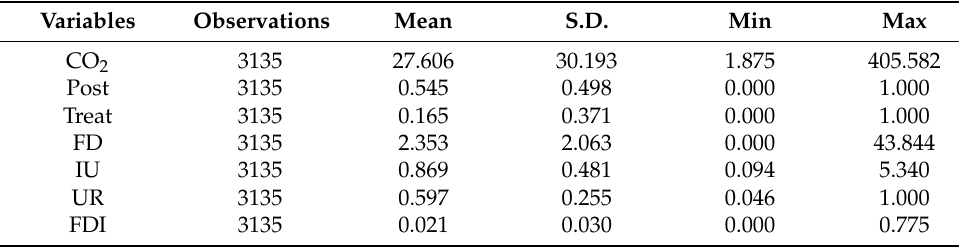
Table 1. Statistical